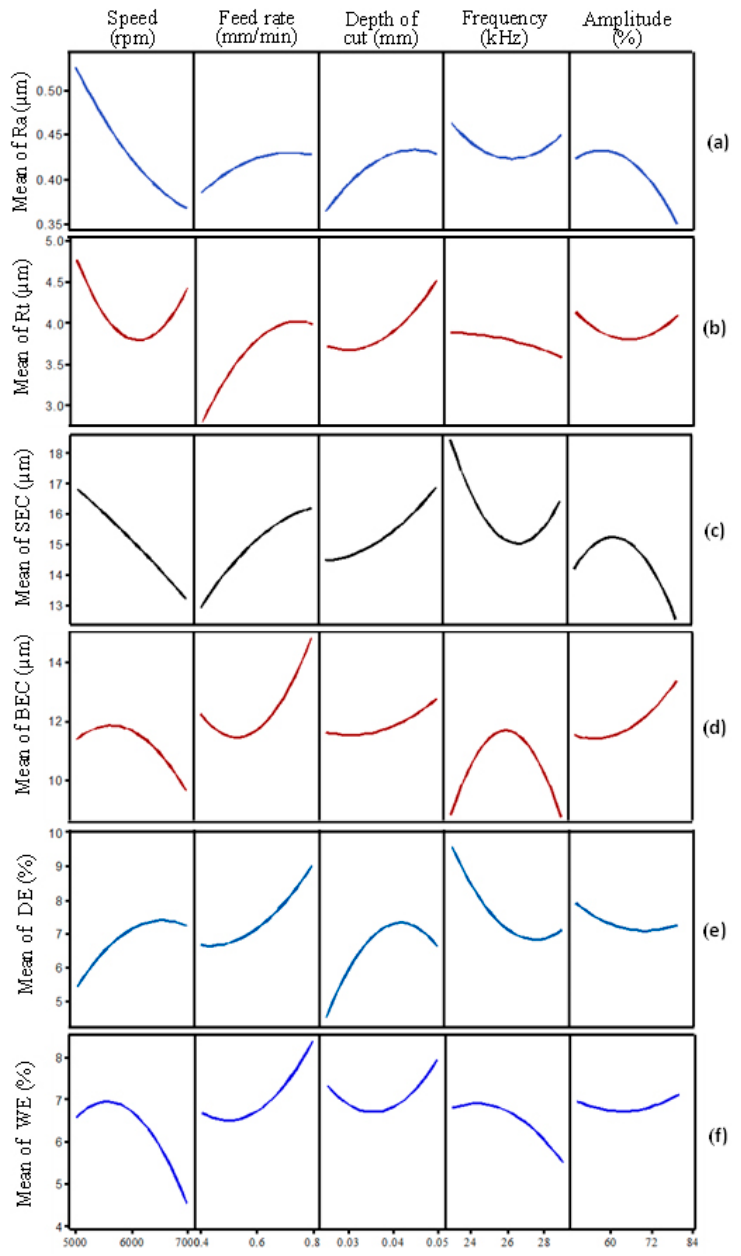
Figure 9. Main effect plots of RUM parameters on ( a ) Ra, ( b ) Rt, ( c ) SEC, ( d ) BEC, ( e ) DE, and ( f ) WE.